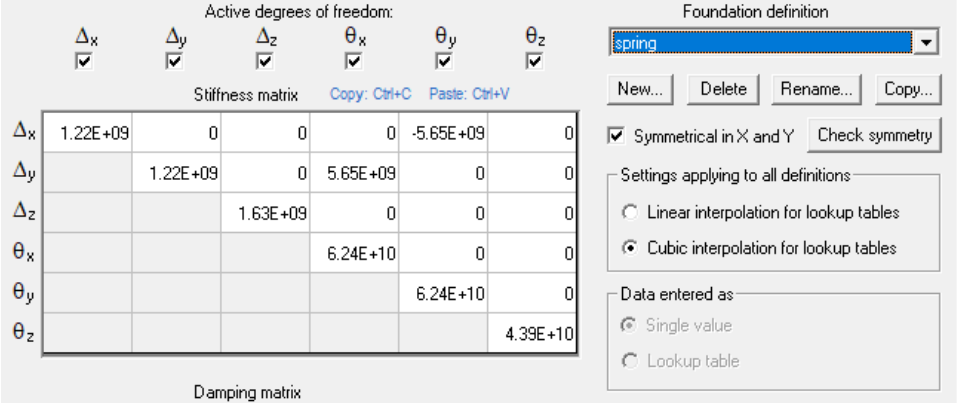
Figure 6. Stiffness matrix analysis model.